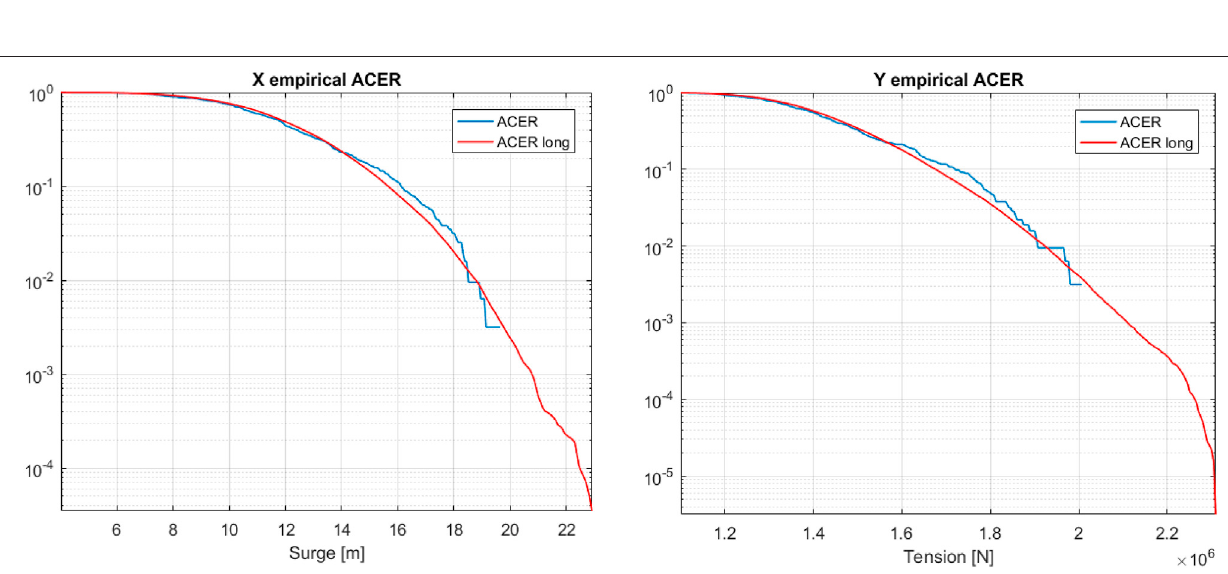
Frontiers in Mechanical Engineering |